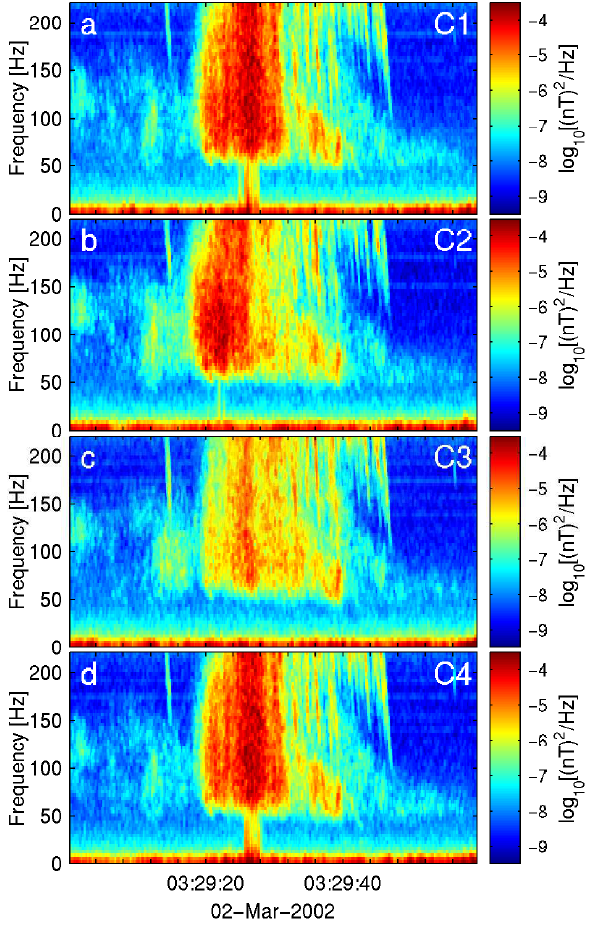
Fig. 4. Distribution of the polar angle, θ , versus time and frequency for C1, C2, C3 and C4. The three vertical lines marking the cen- ters of three stripes observed by C1 and C2 are drawn for future